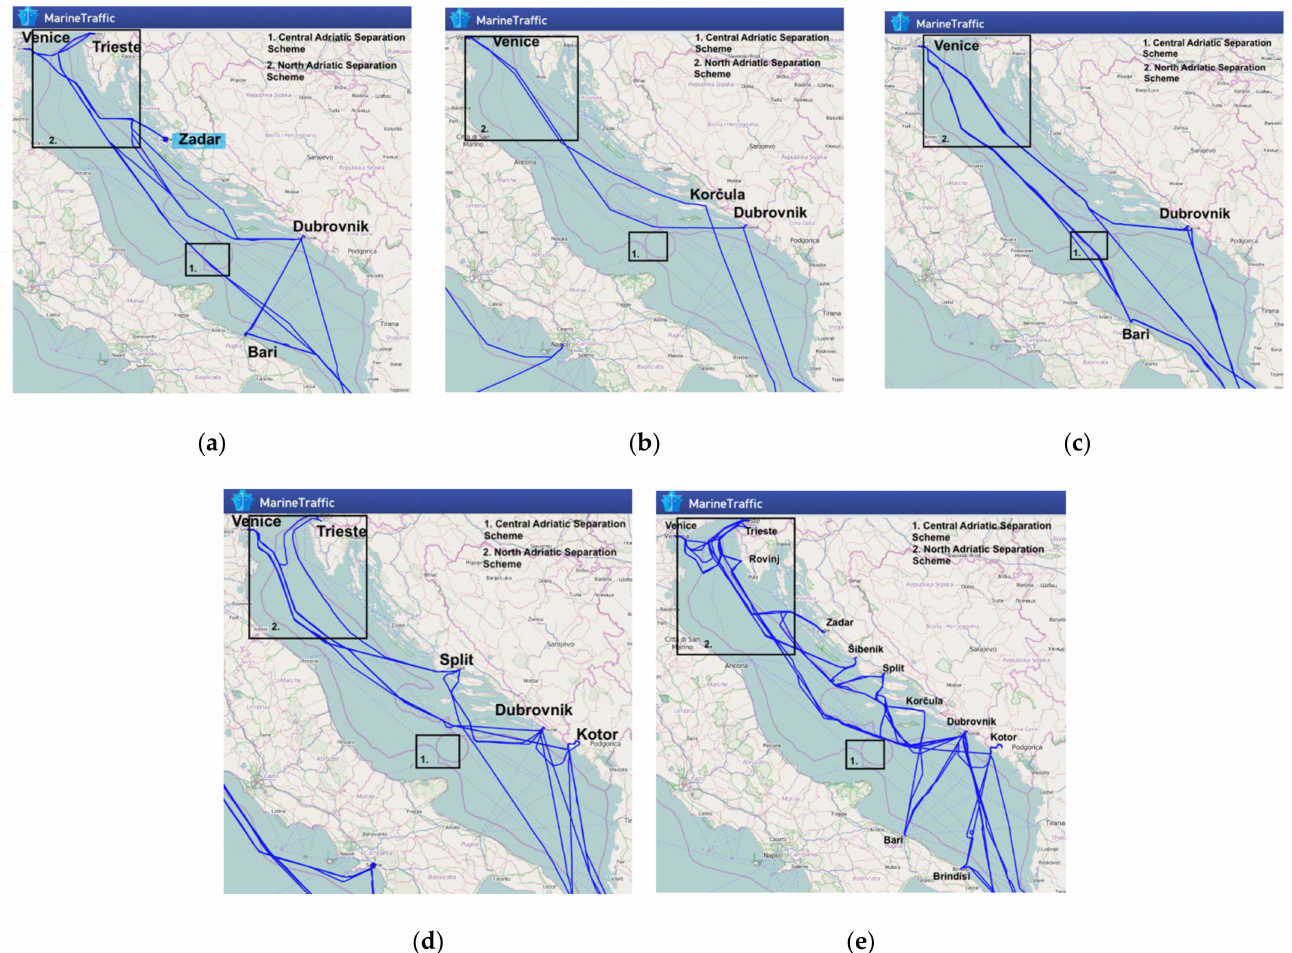
Figure 7. Real cruise ship traffic movement in the Adriatic east coast; ( a ) longitudinal cruise traffic corridor; ( b ) longitudinal cruise traffic corridor via port of Korˇcula; ( c ) international longitudinal cruise ships corridor through Croatian territorial waters in coastal navigation; ( d ) transversal cruise traffic corridor; ( e ) interaction between transversal and horizontal